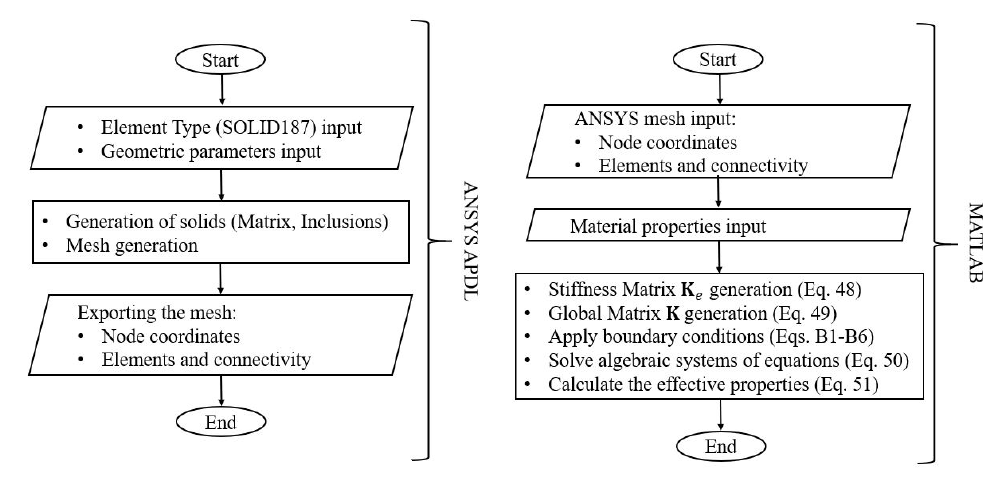
Figure A1. SAFEM-3D